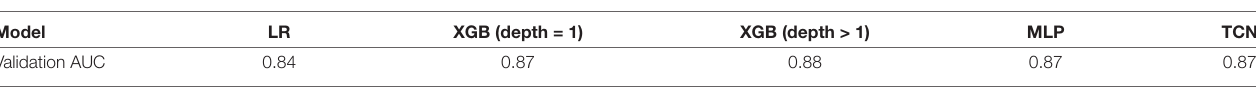
TABLE 6 | Optimal validation AUC score of each model.